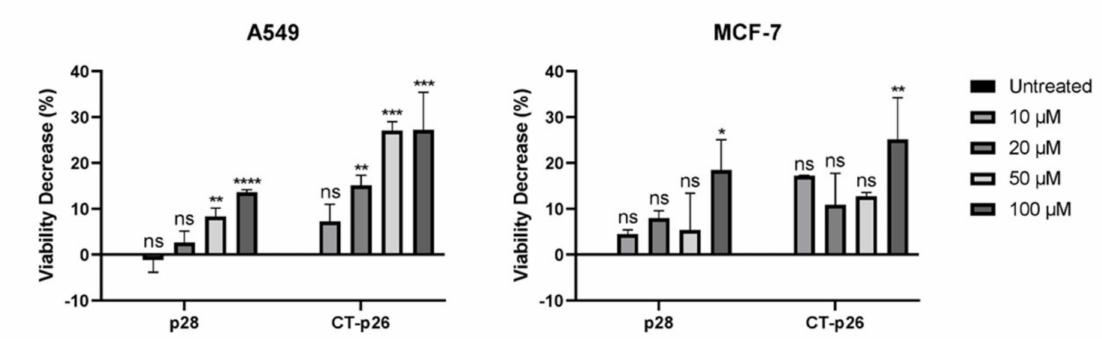
Figure 1. Comparison of cell viability after treatment with p28 and CT-p26 peptides (0 to 100 µ M) in A549 (lung) and MCF-7 (breast) cancer cells incubated over 48 h. Untreated condition (control) consisted of cells incubated with medium only. Values represent the means ± SD, and each condition had at least n = 3. *, **, ***, **** and ns denote significant differences of p < 0.1, p < 0.01, p < 0.001 and p < 0.0001 and differences that were not statistically significant, respectively, when comparing control with treatments.